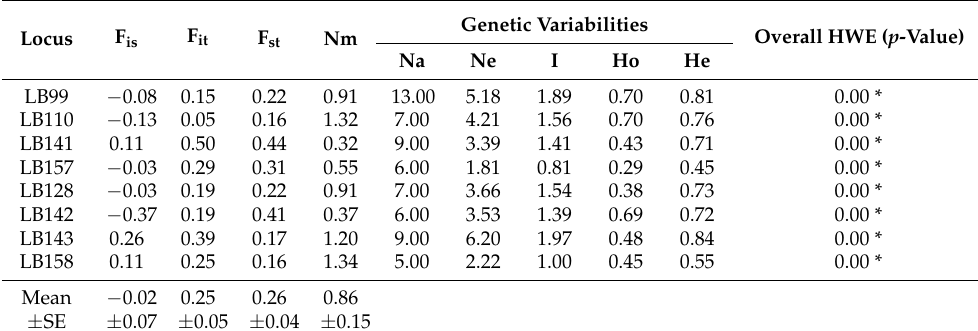
Table 3. Summary of F-coefficients and microsatellite polymorphism, Hardy–Weinberg Equilibrium (HWE) of eight microsatellite primers of leatherback turtles in the Andaman Sea of Thailand. Genetic Variabilities Overall HWE ( p -Value) Locus F is F it F st Nm Na Ne I Ho